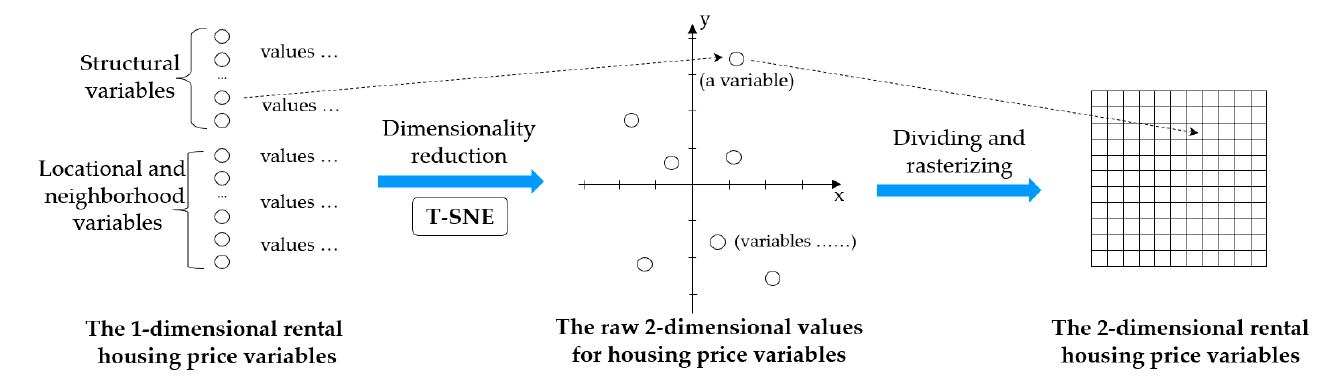
Figure 5. The procedure of transforming the rental housing price variables into two dimensions.